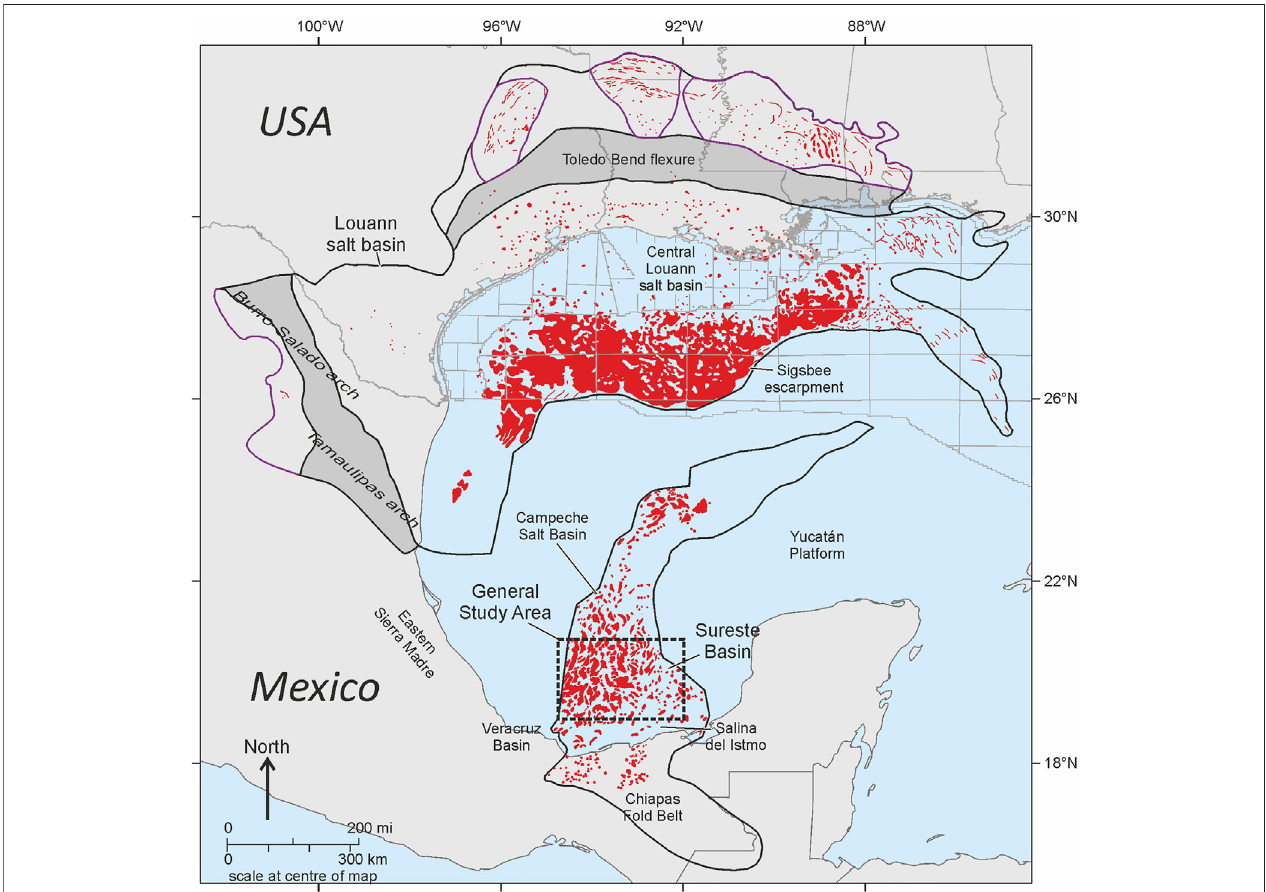
FIGURE1 | Outline ofthe Sureste Basin inSouthernMexico,the study areais located in thedashed box area in offshore section ofthe basin, wecannot reveal the exact location due to con fi dentiality agreements.